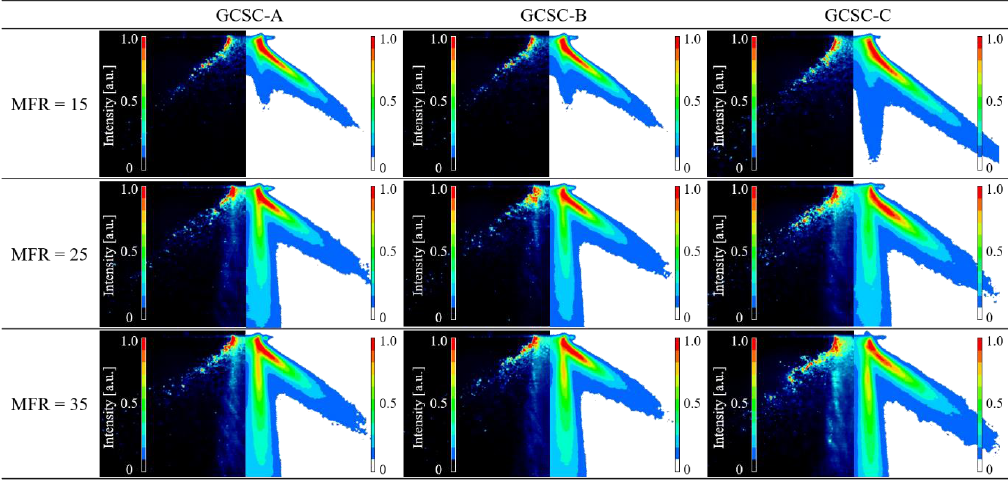
Figure 4. Spray vertical section images (left: conventional, right: intensity).